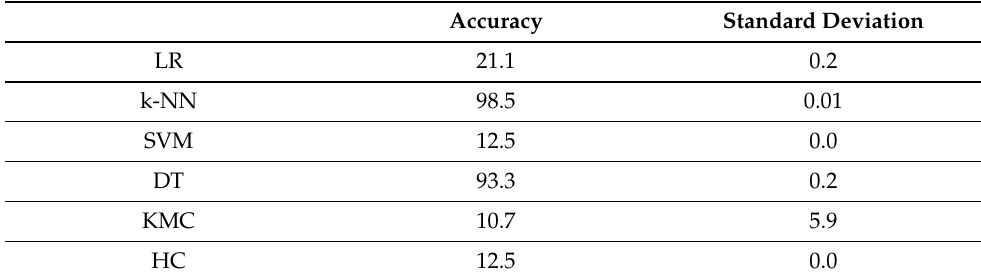
Table 5. k-fold result per algorithm.